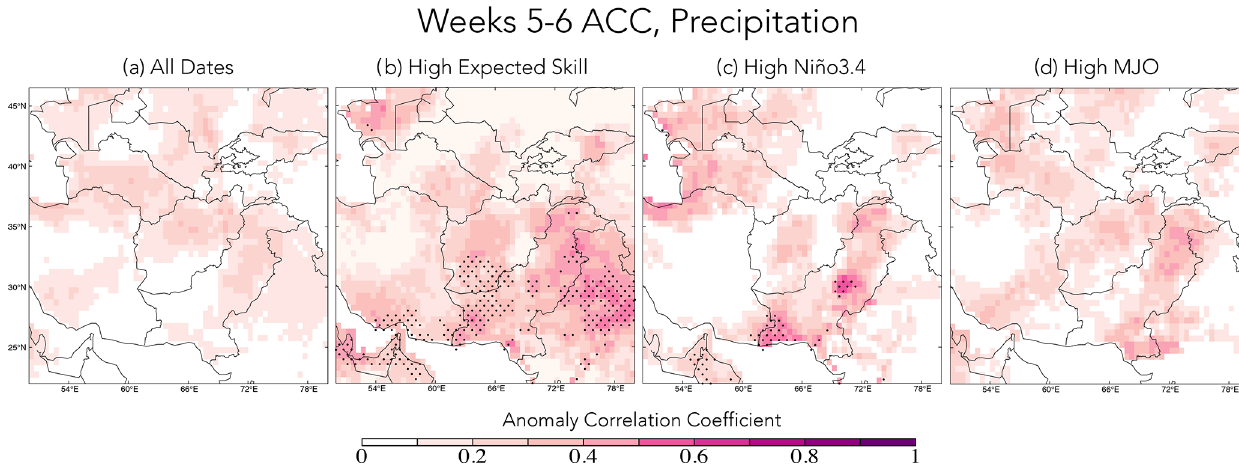
Figure 4. As in Fig. 3 but for weeks 5–6